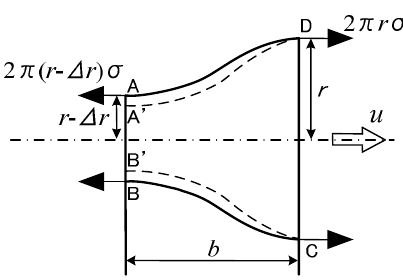
Fig.8 Schematic diagram of neck growth caused by surface tension